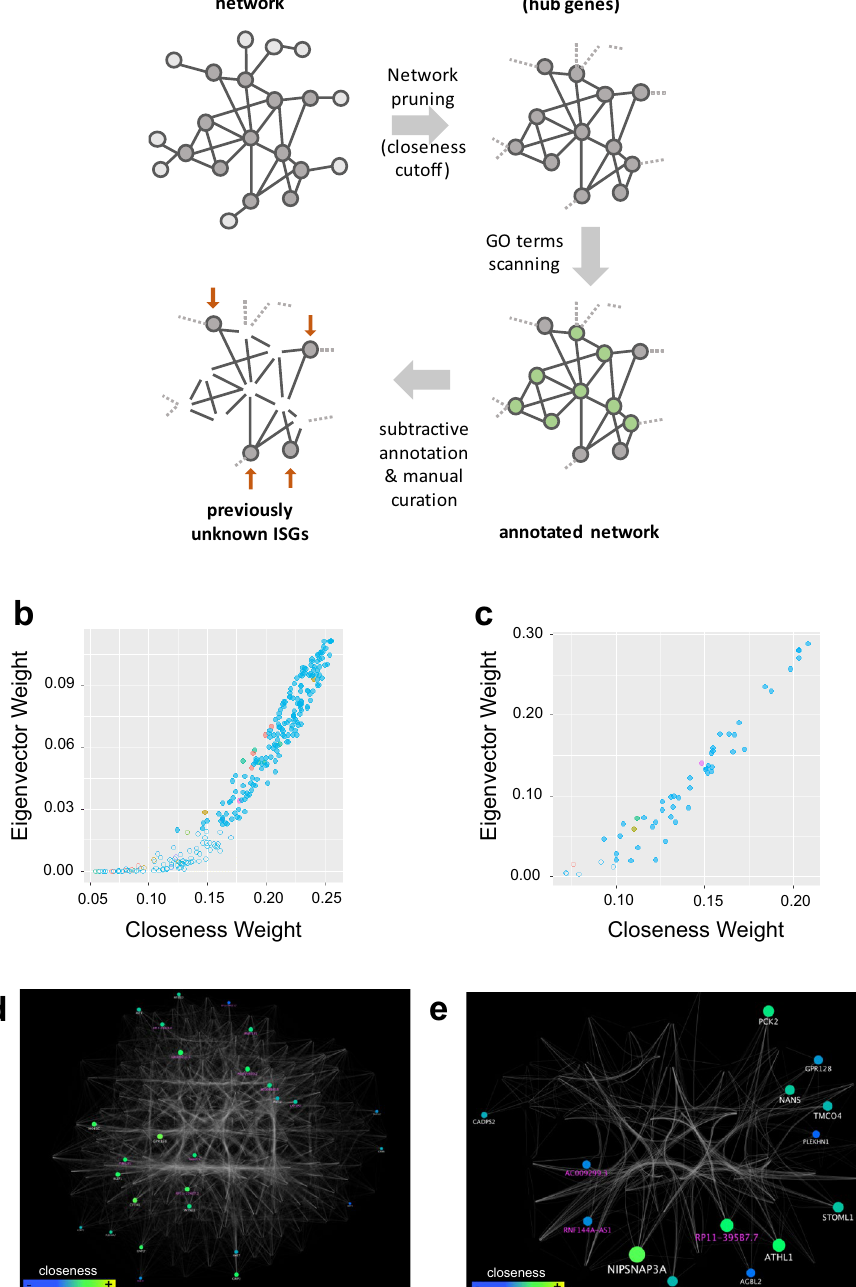
Figure 4. Green and Tan sub networks of putative new ISGs. ( a ) The method for extraction of putative, previously unknown IFN sensitive genes, using network pruning by centrality metrics cutoffs and subtractive gene ontology annotations. ( b ) Eigenvectors and closeness of genes in the Green module. These two metrics are linearly correlated above a certain threshold: higher eigenvector values correspond to higher closeness and identify hub genes. Nodes with eigenvector < 0.02 are defined as peripheral and depicted as transparent. ( c ) Eigenvectors and closeness of genes in the Tan module. ( d ) Cytoscape-generated sub-network for the Green module. Gene ontology annotation of surviving nodes after subtractive gene ontology annotation are displayed, while nodes (genes) associated to immune-related biological processes are not, allowing focus on non-peripheral novel players. Eigenvector is proportional to node size, closeness to color gradient. ( e ) Similar cytoscape-generated sub-network for the Tan